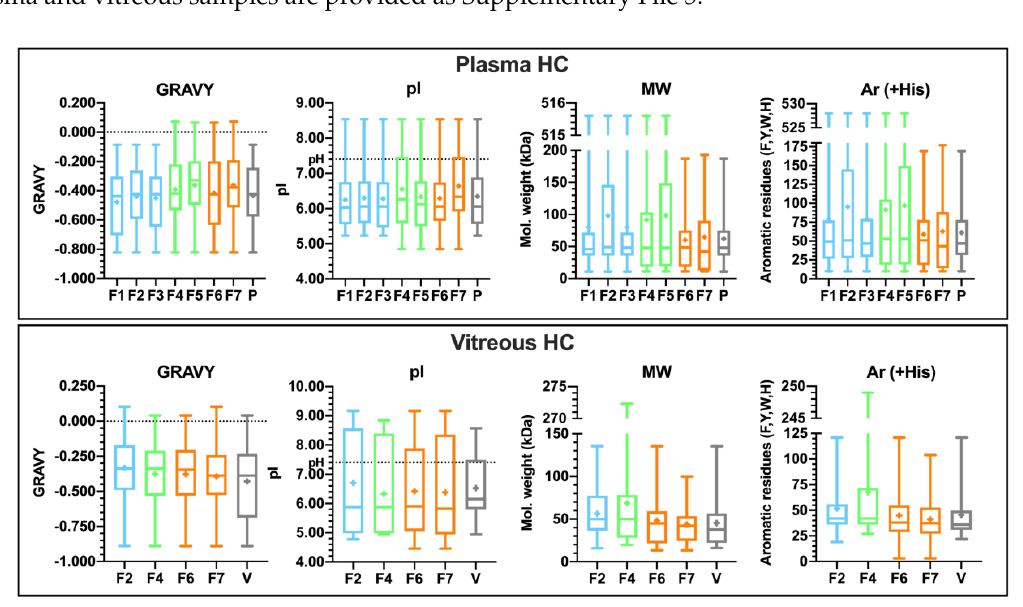
Figure 7. Properties of the top 20 enriched proteins in the hard coronas (HC) and the plasma or vitreous sources (P or V) with the max–min range, first and second quartiles, median, and mean (+). The color-coded groups are neutral 100 nm ( blue ), anionic 100 nm HA-coated ( green ), and small 50 nm anionic ( orange ) liposomes. GRAVY: grand average of hydropathy (positive score indicates hydrophobicity); pI: theoretical isoelectric point (pI under pH indicates net negative charge); MW: molecular weight; Ar (+His): aromatic residues phenylalanine, tyrosine, tryptophan, and histidine. Note the different y -axis ranges.